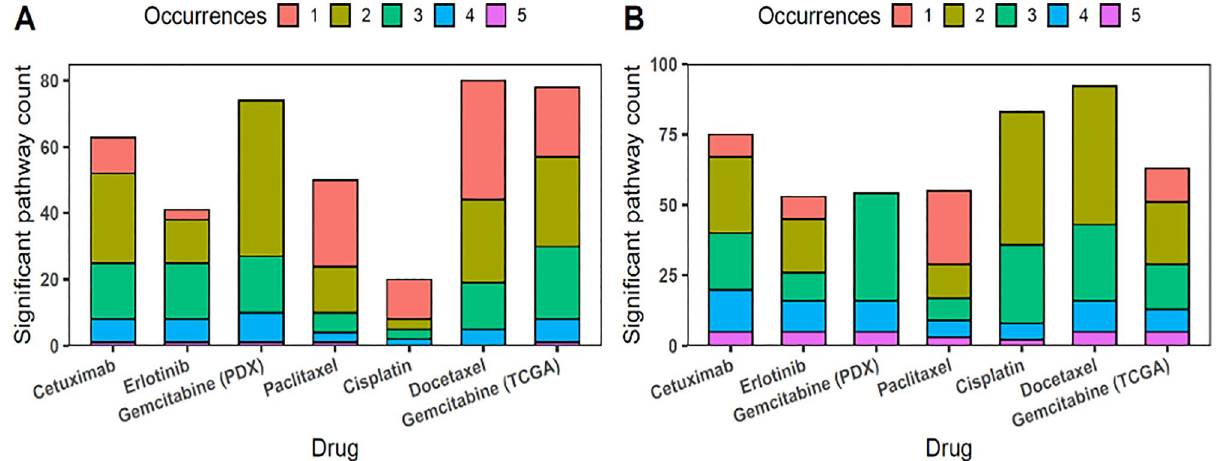
Figure 3. Annotation of selected genes to IPA pathways across all drug-specific classifiers for responder ( A ) and non-responder ( B ) classes. Occurrences bars show how many times that part of annotations is also found in sets for other classifiers. Data were analyzed through the use of QIAGEN Ingenuity Pathway Analysis (IPA), 2022 Summer Release (July) data, with client 01–20-04 (installed on 14 Sep 2021).